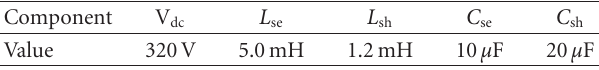
Table 1: Values of the components of the UPQC. Component